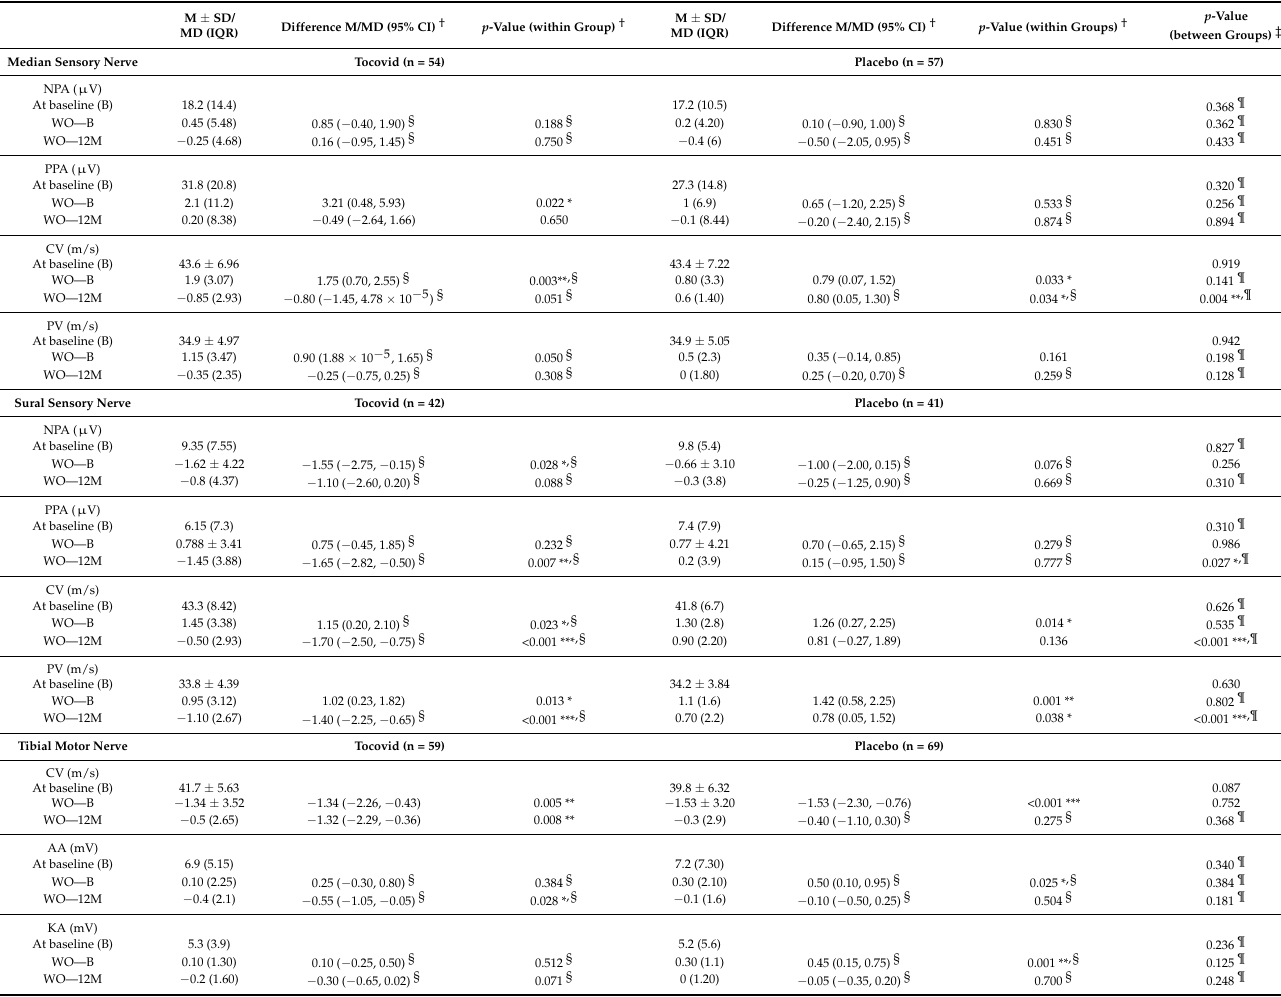
Table 10. Comparison of nerve conduction parameters between intervention groups at 6 months